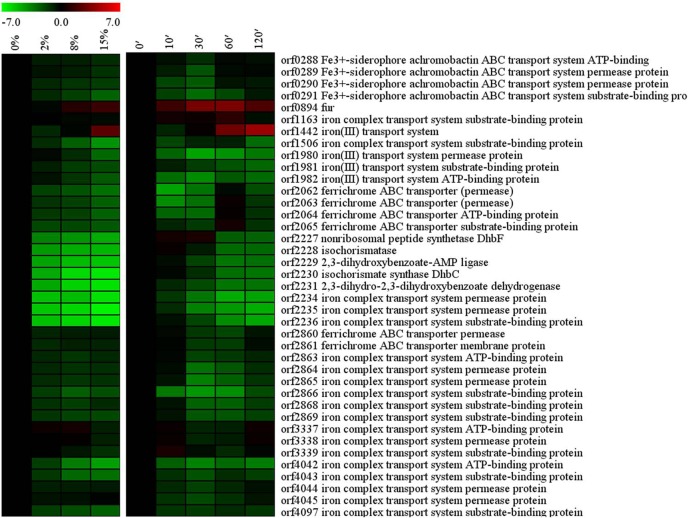
Alterations in iron homeostasis related genes.Expression profiles are displayed on the basis of log2 ratios.